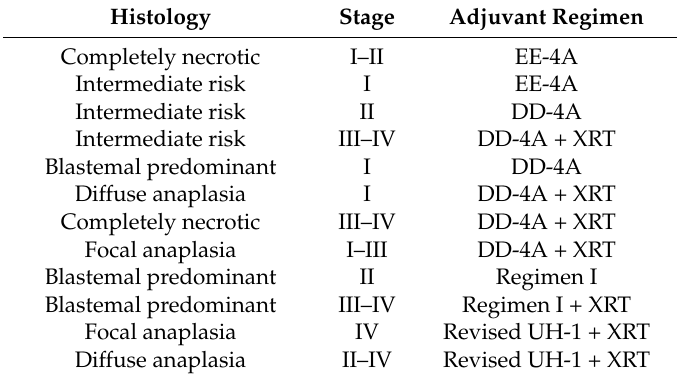
Table 1. Determination of adjuvant therapy after surgical resection of bilateral Wilms tumor